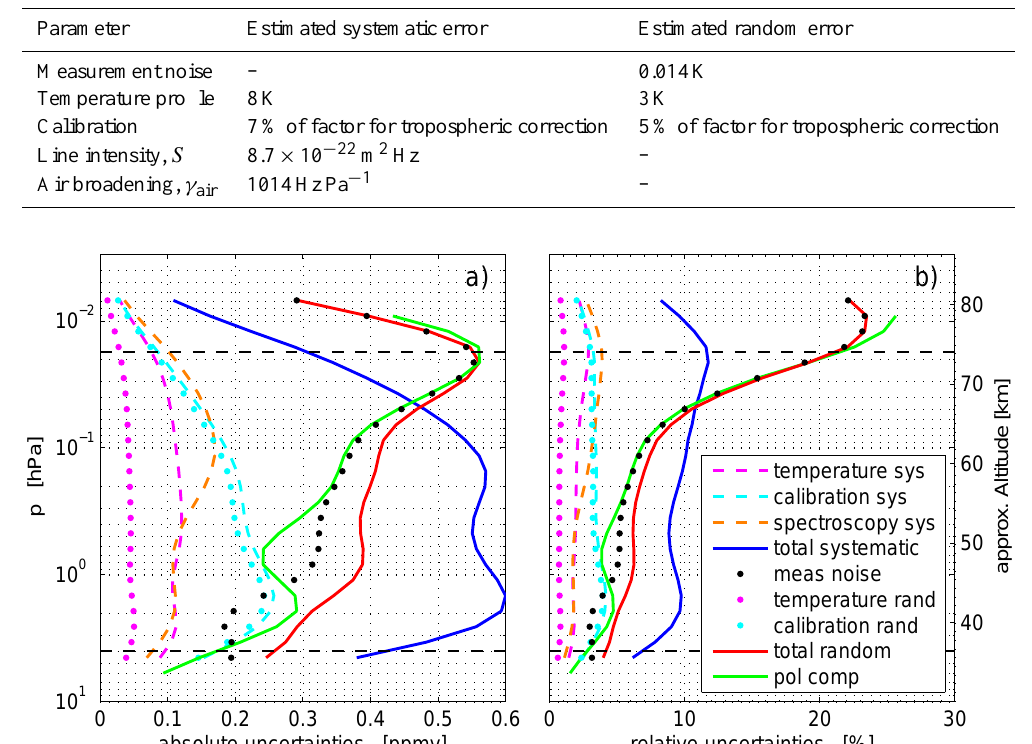
Table 2. Estimates of the errors of the relevant forward model parameters. Based on Straub et al. (2010) and Haefele et al. (2009)